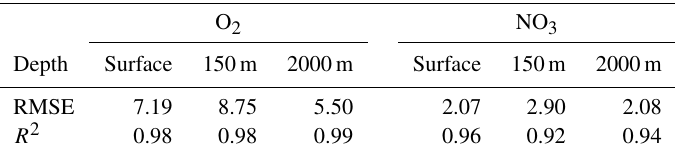
Table 2. Differences between the oxygen (O 2 , µmolL − 1 ) and nitrate (NO 3 , µmolL − 1 ) data sets used for initializing IPSL-CM5A-LR (WOA1994) and the data sets used for assessing its performance